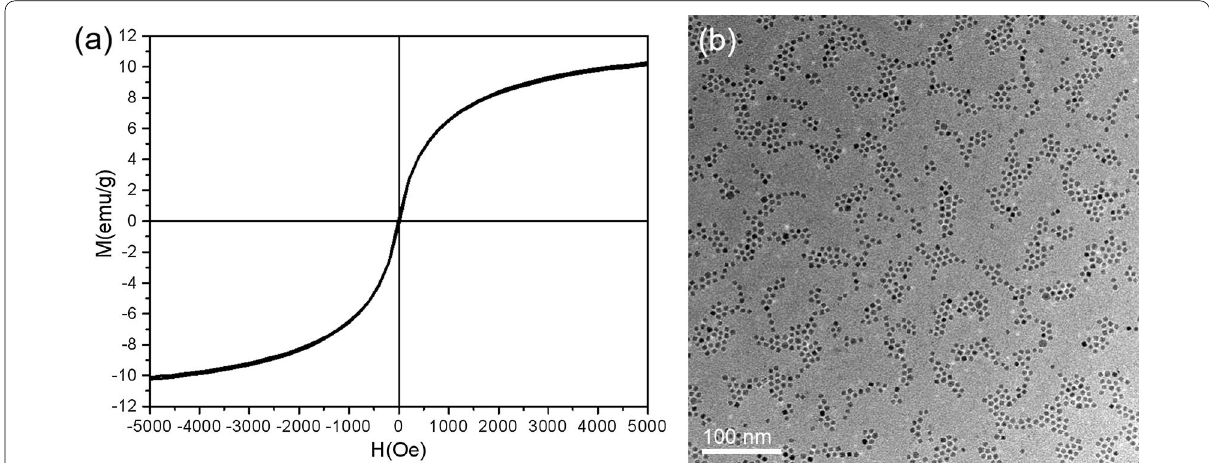
Fig. 6 a Hysteresis loop measured at 300 K of densely packed 2D self-assembled Fe nanoparticle arrays, showing that the nanoparticles are in the superparamagnetic states. b TEM image of TiN nanoparticle arrays deposited on a TEM grid covered by amorphous carbon film, showing that the nanoparticle arrays are composed of domains of ordered densely packed 2D monolayers